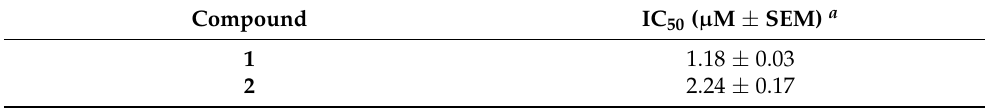
Table 1. Evaluation of pyrimido[4,5- b ]indoles 1 and 2 in a NanoBRET TM TE intracellular GSK-3 β